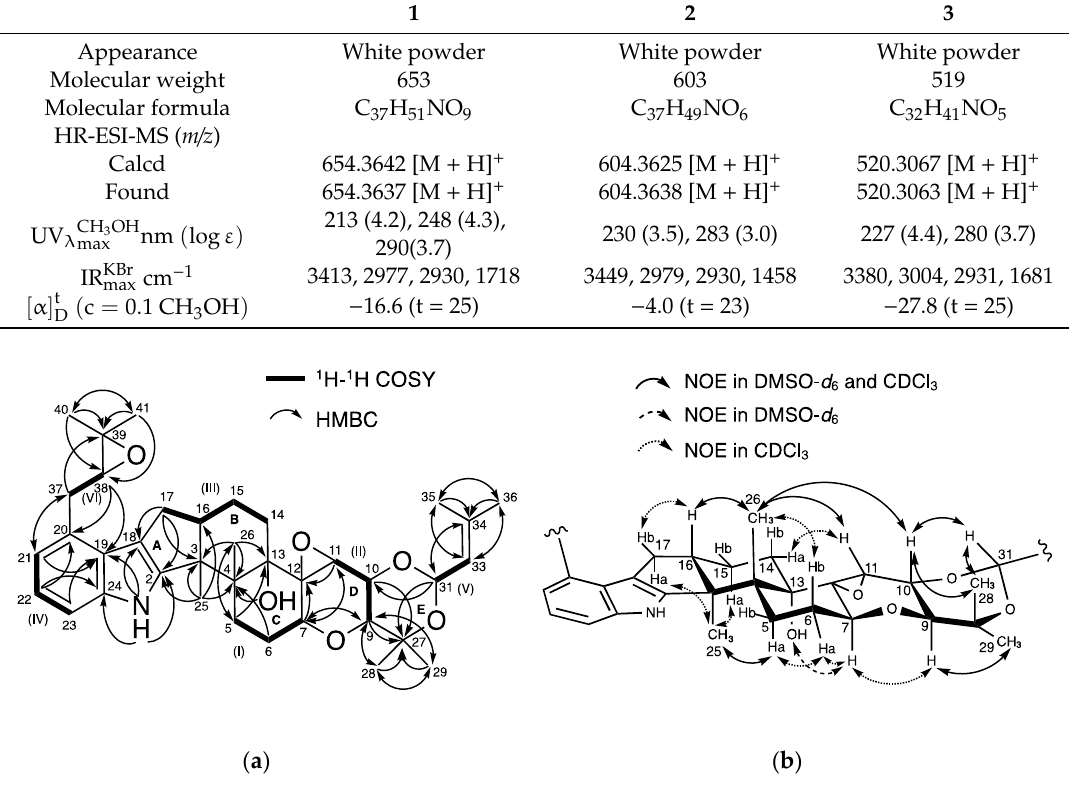
Figure 3. Structural elucidation of 2 : ( a ) Key correlations in 1 H- 1 H correlation spectroscopy (COSY) and heteronuclear multiple bond correlation (HMBC) spectra; ( b ) nuclear Overhauser effect spectroscopy (NOESY) experiments.